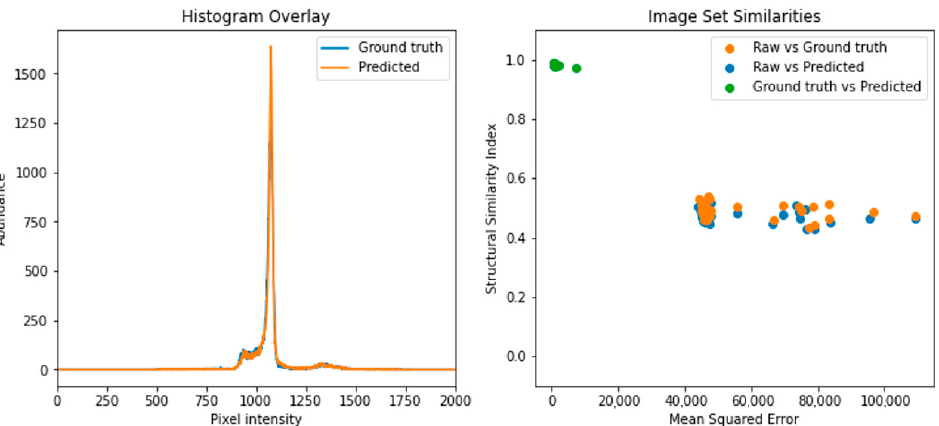
Figure 4. Quantifying a high degree of quantified similarity between ground truth and predicted images. Comparing a representative pixel intensity histogram of a ground truth and predicted image ( left ) showed a high degree of overlay and that peaks were present in similar areas at similar amplitudes, indicating a similar distribution of pixel intensities within each image. Structural components of image groups were compared ( right ) using mean squared error (MSE) and structural similarity indexes (SSIs) which revealed a) high average MSE (58,674 ± 17,766 and 58,008 ± 17,319, n = 32) with low average SSI (0.49 ± 0.025 and 0.48 ± 0.024, n = 32) between raw vs. ground truth and raw vs. predicted image groups, respectively, b) low average MSE (1028 ± 1201) and high average SSI (0.98 ± 0.0035) when comparing ground truth vs. predicted images. These high SSI and low MSE values confirm the suitability of a trained generative adversarial network to perform highly accurate ovine CT image processing.